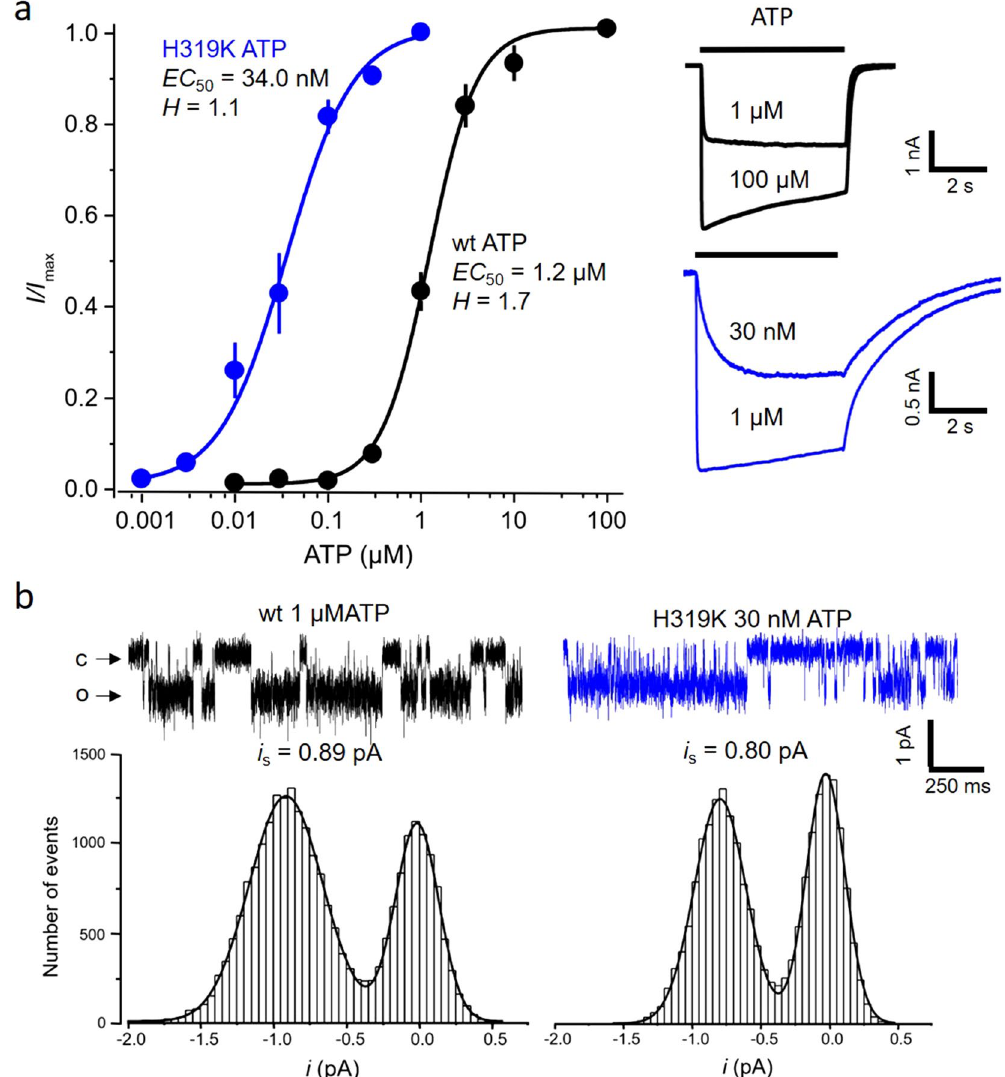
Figure 1. Currents in wild type and H319K channels. The membrane voltage was generally − 50 mV. ( a ) Concentration-activation relationships for wt (black) and H319K currents (blue) measured in whole cells. The data points were fitted with Hill curves according to Eq. (4) yielding the indicated parameters. The insets right show typical current time courses evoked by ATP pulses at the indicated concentrations. ( b ) Single-channel currents measured in the cell-attached configuration. Representative traces and amplitude histograms to determine the amplitude of the single-channel current i s (see